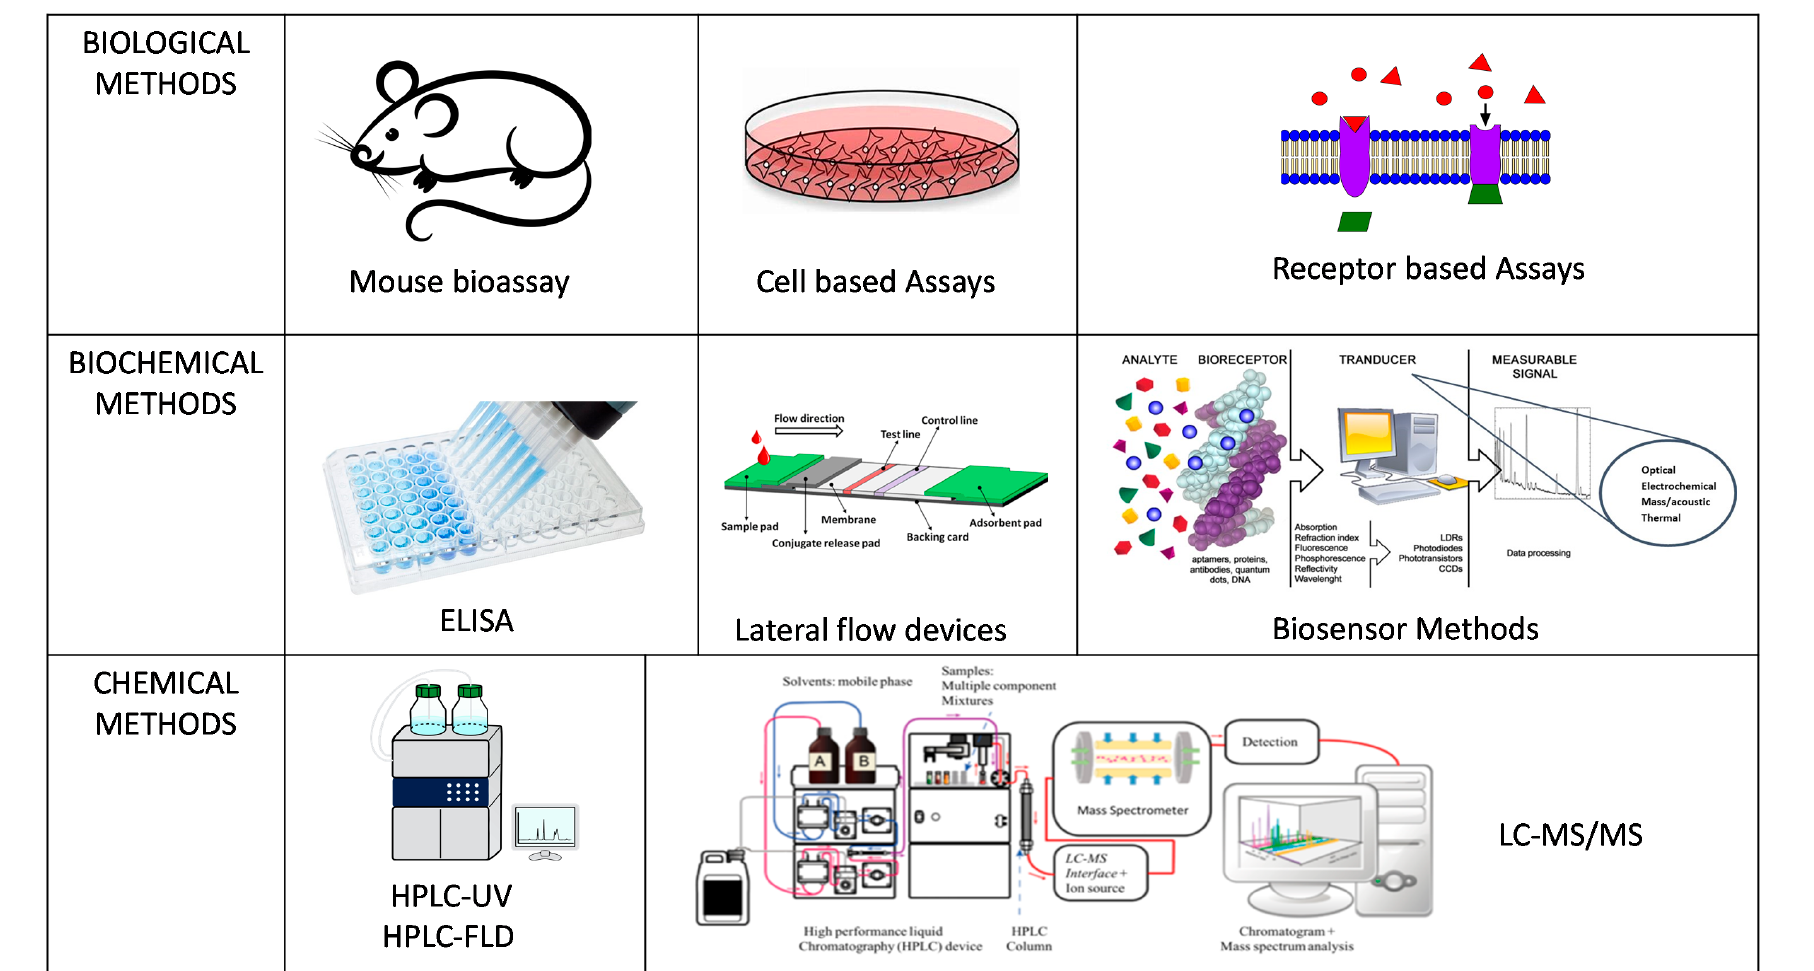
Figure 2. Schematic summary of the various methods of analysis for marine biotoxins.